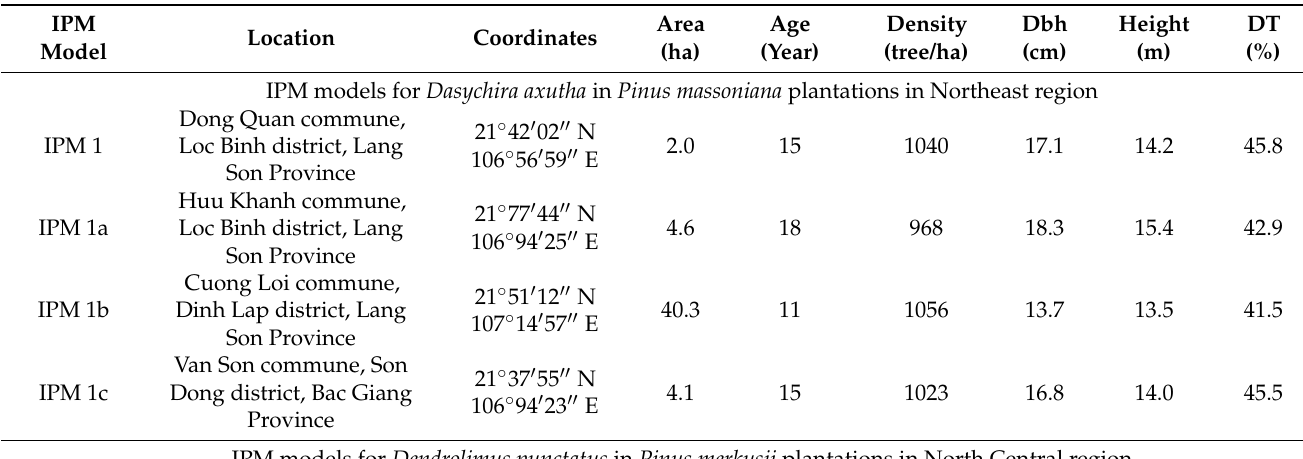
Table 1. Plantation details where the eight integrated pest management models were